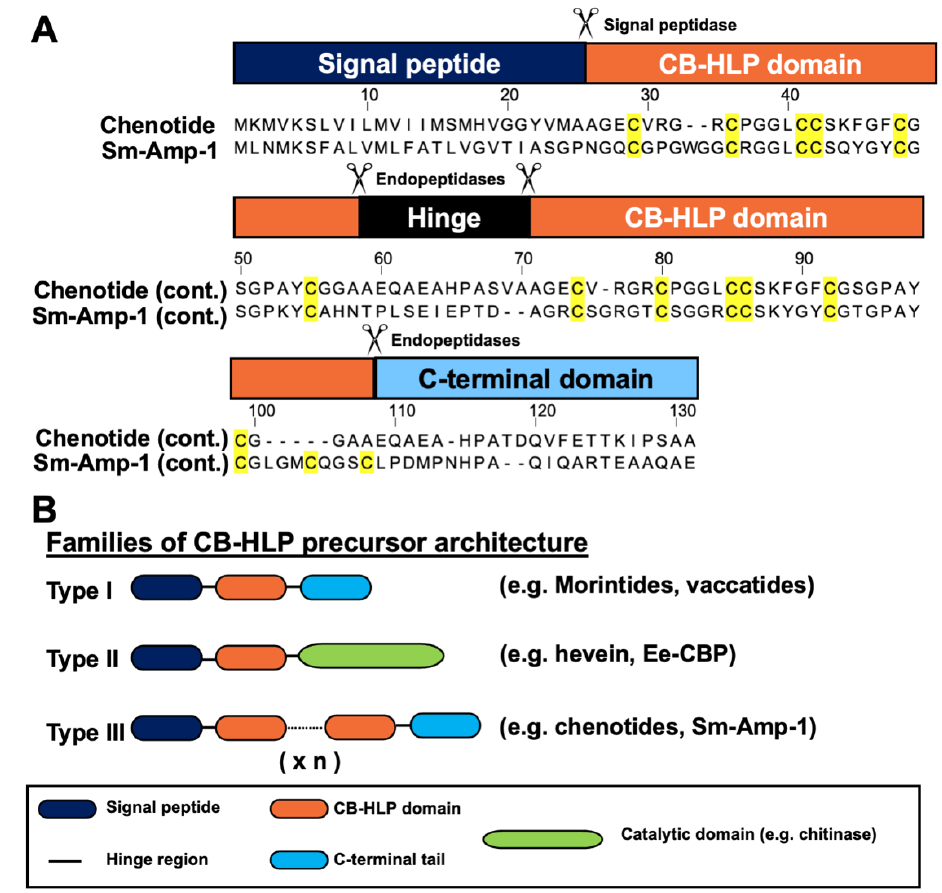
Figure 7. Biosynthesis pathway of chenotides. ( A ) Alignment of precursor sequence of chenotide and Sm-Amp-1 (UniProtKB-E1UYT9). Chenotide precursor contains an unusual three-domain precursor, consisting of an N-terminal signal peptide, two identical tandem-repeating mature CB-HLP domains, and a C-terminal tail. Signal peptide is cleaved by signal peptidase, C-terminal domain, and hinge region are cleaved by an alanine endopeptidase to release each mature chenotide domain. ( B ) Schematic illustration of type I (non-cargo-carrying), type II (cargo-carrying), and type III (tandem-repeating) precursor architectures of chitin-binding hevein-like peptides. x n represents number of CB-HLP domain.